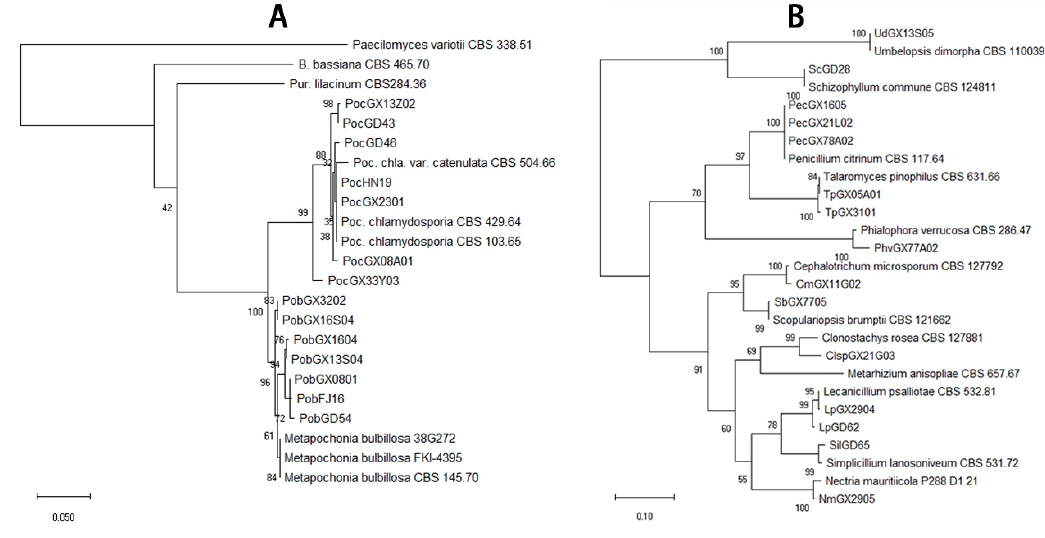
Figure 4. Phylogenetic tree of the Pochonia / Metapochonia spp. ( A ) and other ( B ) isolates.